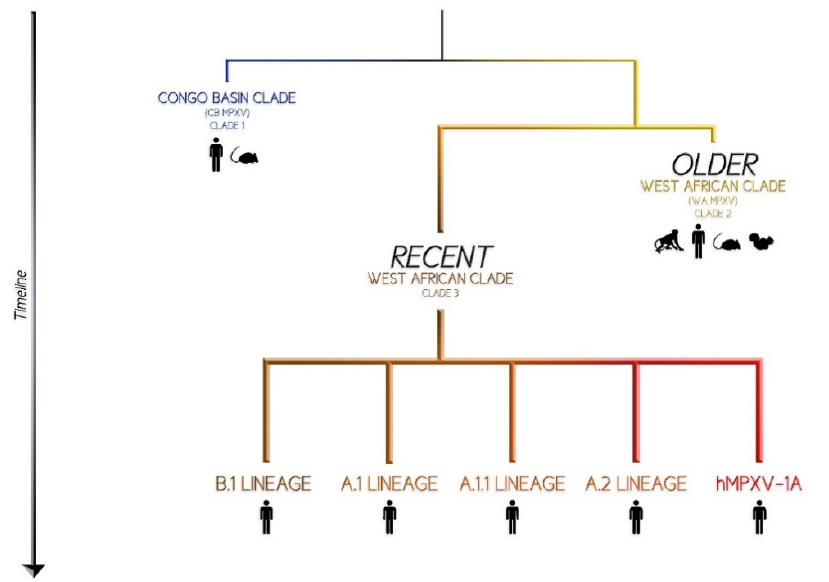
Figure 1. “Where does MPXV come from?” a graphical Figure 1. “ Where does MPXV come from?” a graphical representation. Comparison between 2022 MPXV genomes and the 2017/2019 outbreaks identified 47 shared single nucleotide differences, an unexpectedly large number in a short space of